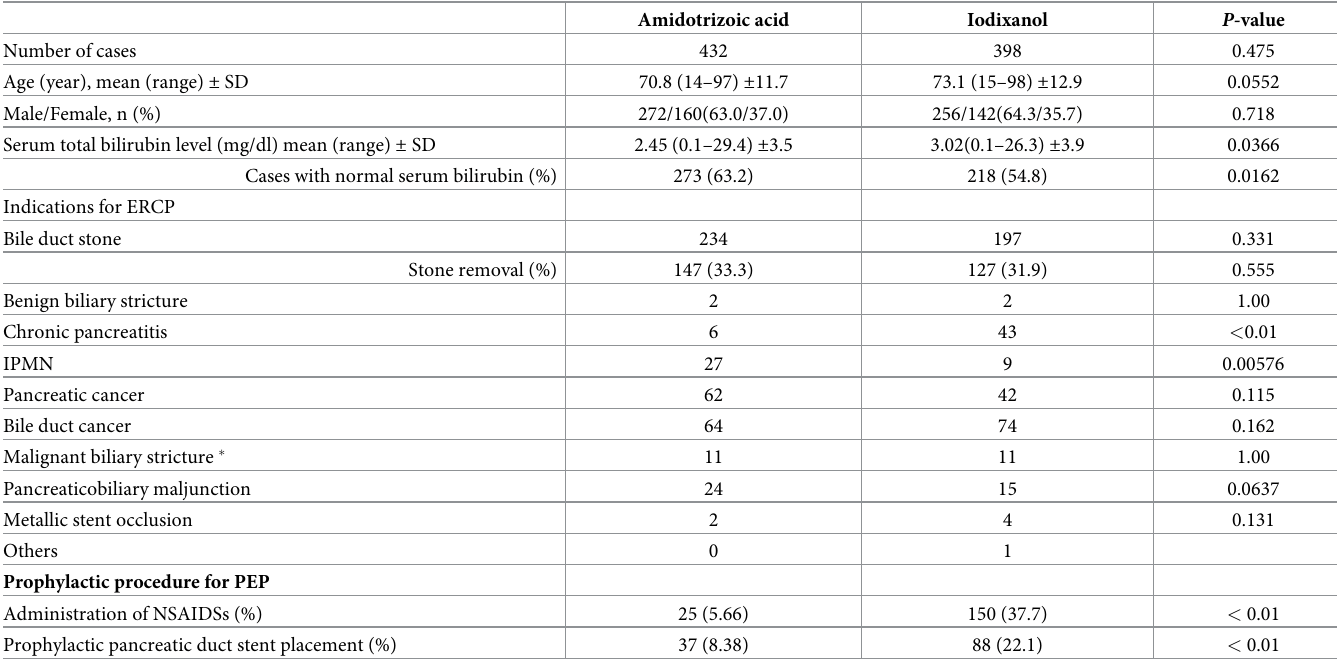
Table 2. Clinical characteristics of patients who underwent